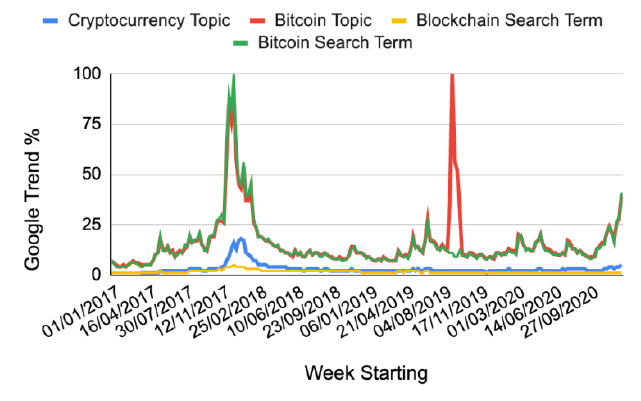
Figure 11: Google trend results for ‘Cryptocurrency’ and ‘Bitcoin’ topics , and ‘Blockchain’ and ‘Bitcoin’ search terms .